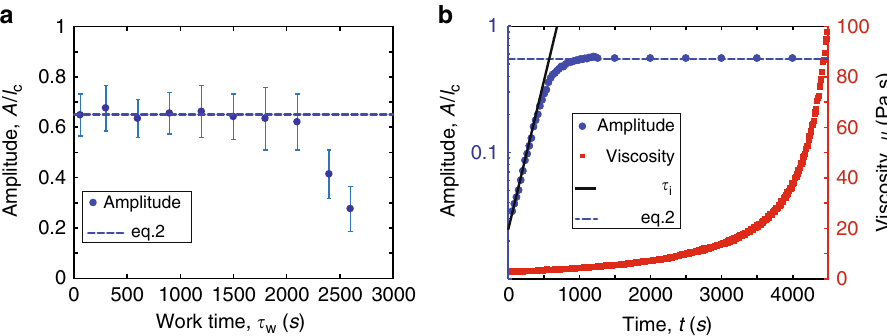
Fig. 3 Mechanics of amplitude selection. a Average fi nal amplitude of the drops normalized by the capillary length for PDMS versus the work time τ w , the time at which the plate is inverted (initial thickness of the fi lm, h 0 = 270 μ m). The dashed blue line is the prediction of the fi nal amplitude, Eq. 2. The error bars correspond to the standard deviation of the amplitude of the drops in the lattice. b Measured amplitude of the droplets A ( t ) (blue points, initial thickness of the fi lm, h 0 = 315 μ m) and variation of the viscosity μ ( t ) (red squares). The solid black line (resp. the dashed blue line) is the prediction of the exponential growth with time scale τ i (resp. of the fi nal amplitude by Eq. 2)